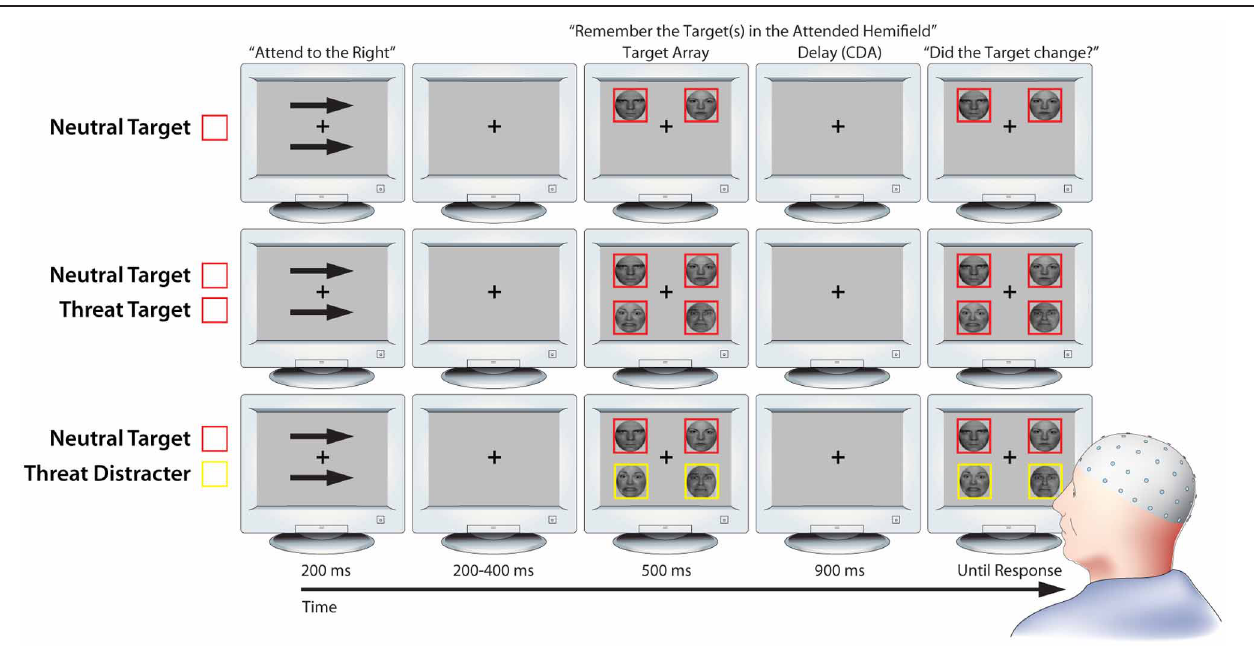
perceptual and preparatory motor activity when calculating CDA. Delay-spanning CDA was extracted from the 900ms delay epoch. For ease of interpretation, the schematic is not to scale. Portions of this figure were reprinted by permission from Macmillan Publishers Ltd.: Nature Reviews Neuroscience (Houdé and Tzourio-Mazoyer, 2003; Peelen and Downing,